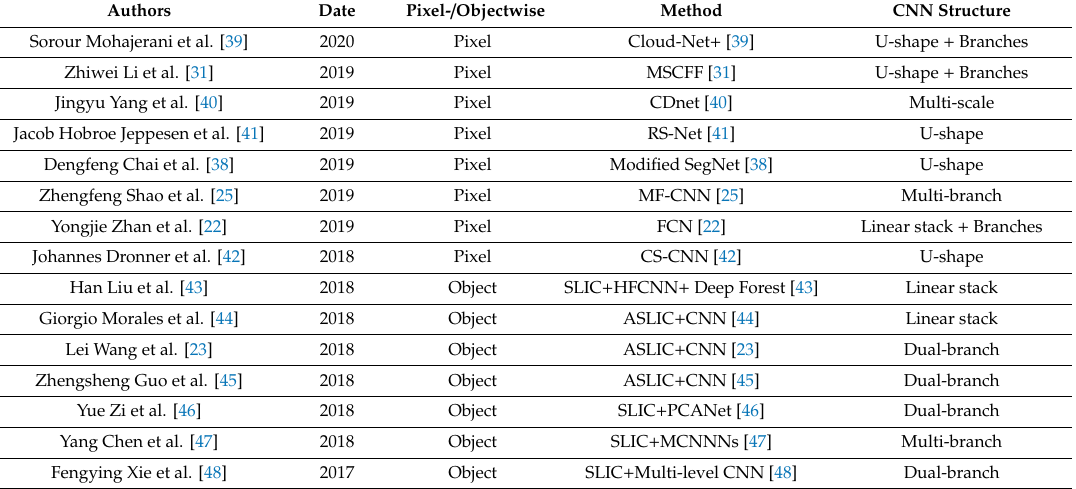
Table 1. Summary of the main convolutional neural network (CNN)-based methods for cloud detection in recent